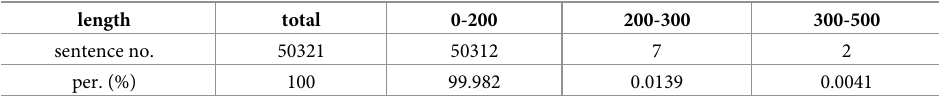
Table 1. Lengths of sentences in